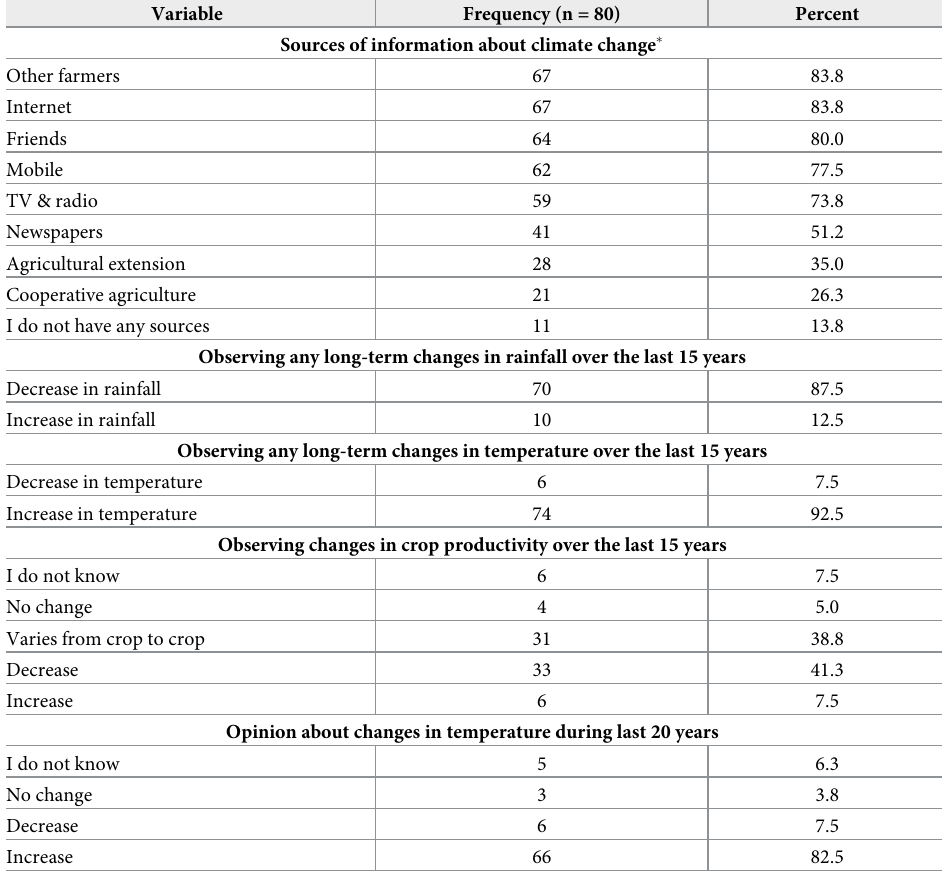
Table 3. Frequency distribution of the farmer’s sources of information and personal observations about climate